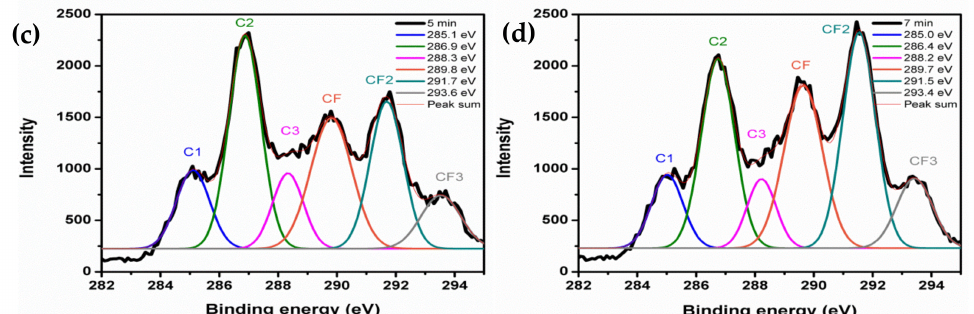
Figure 12. XPS analyses of C1s spectra of ( a ) untreated, ( b ) 3 min, ( c ) 5 min, and ( d ) 7 min at 200 mTorr 50